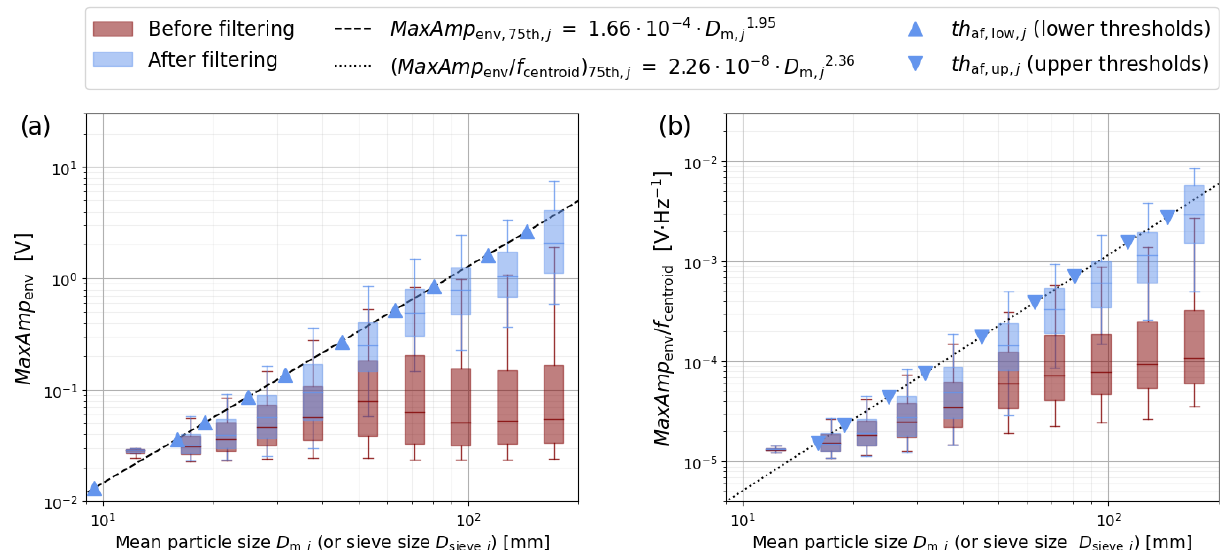
Figure 5. Range of signal responses obtained for each individual grain-size class fed into the flume before (red boxes) and after (blue boxes) filtering out apparent packets using the filtering criterion in Eq. (3), with (a) the maximum amplitude of the envelope MaxAmp env and (b) the ratio MaxAmp env /f centroid as functions of the mean particle diameter D m ,j . In (a) , the lower threshold values th af , low ,j are obtained by replacing D m ,j with the lower sieve sizes ( D sieve ,j ) in the equation of the dashed power-law regression line (Eq. 4). In (b) , the upper threshold values th af , up ,j are obtained by replacing D m ,j with the upper sieve sizes ( D sieve ,j + 1 ) in the equation of the dotted power-law regression line (Eq. 5).